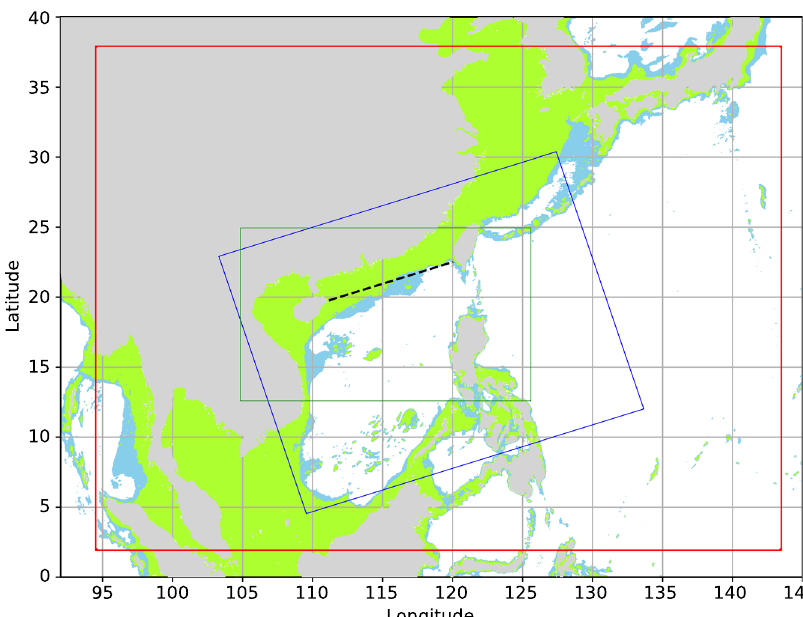
Fig. 9 COAWST domains. Domains of the outer (red box) and inner (green box) grids of WRF, and ROMS and SWAN (blue box). Green and blue colors denote ocean depths of <200 m and between 200 and 1000 m, respectively. Black dashed line represents the data line used in the Hovmöller diagrams in Fig. 6.